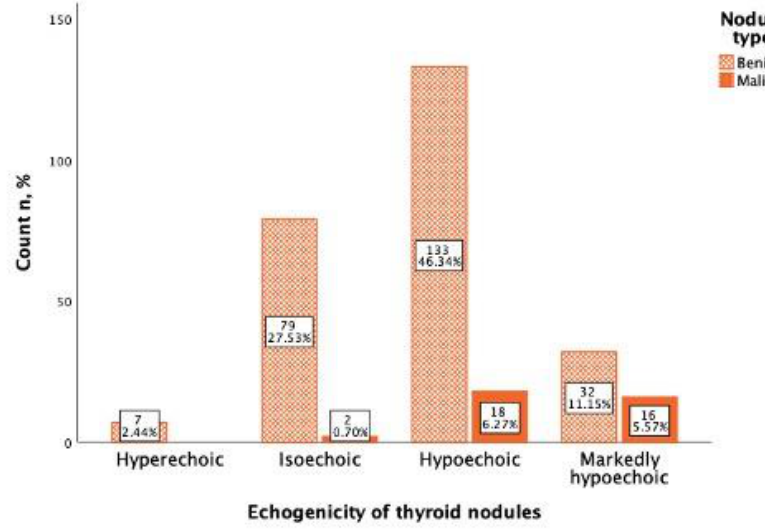
Figure 4. Thyroid nodule malignancy depending on nodule echogenicity. Benign nodules (orange) and malignant nodules (red) are displayed in four ultrasound echogenicity categories.